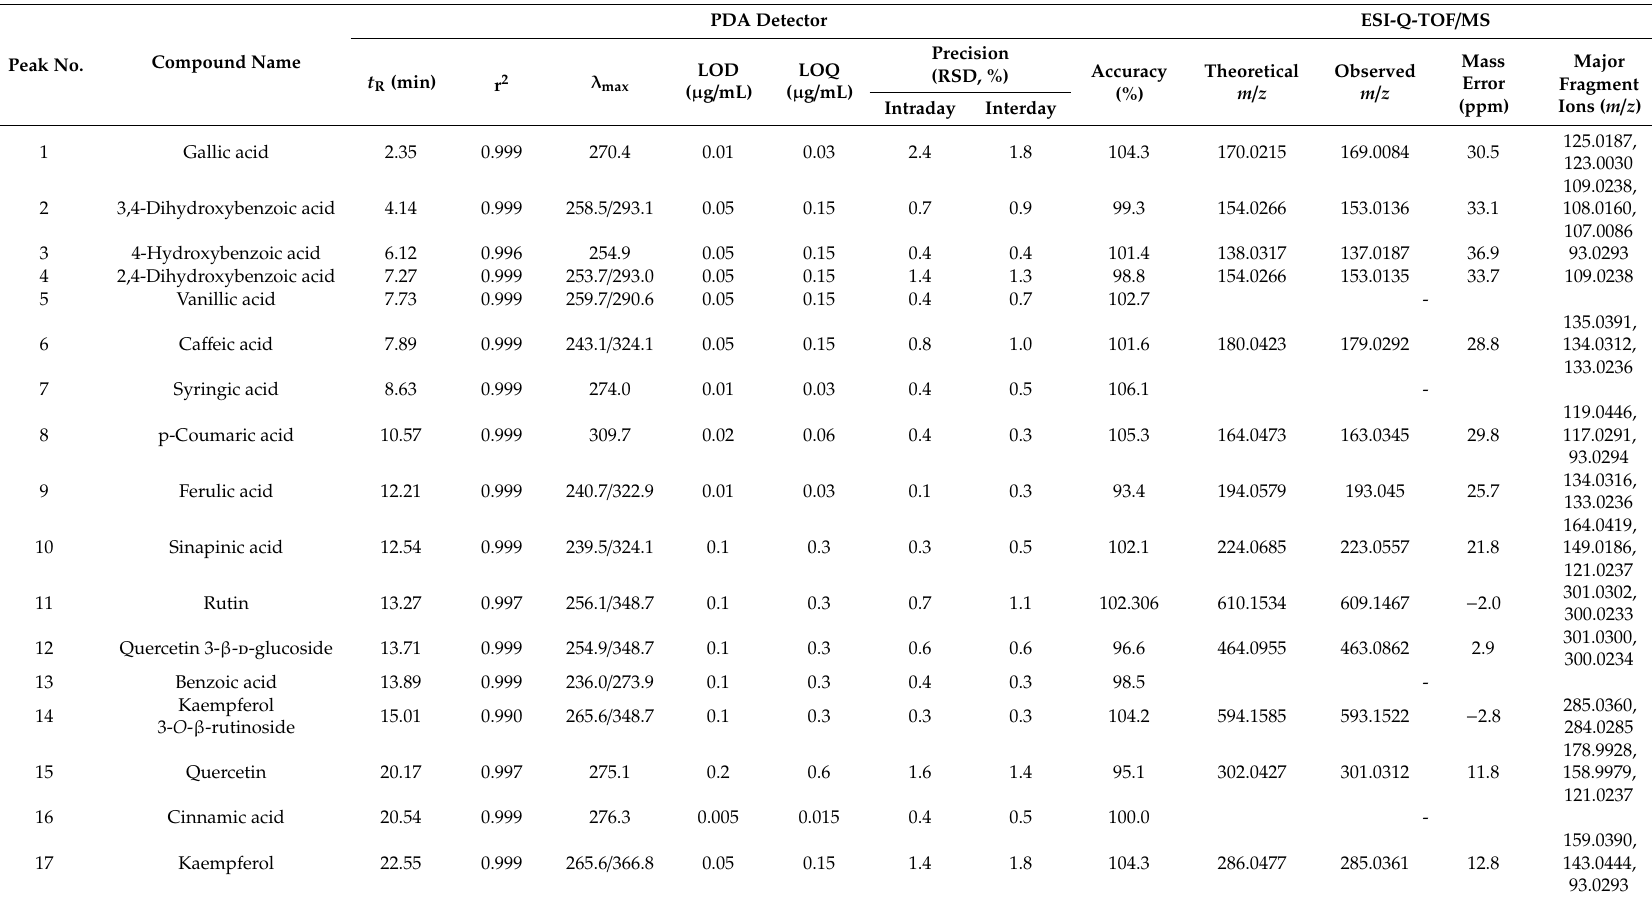
Table 1. Results of method validation and characterization of mass information for 17 phenolic compounds by UPLC-PDA / ESI-Q-TOF / MS. Note: LOD, limit of detection; LOQ, limit of